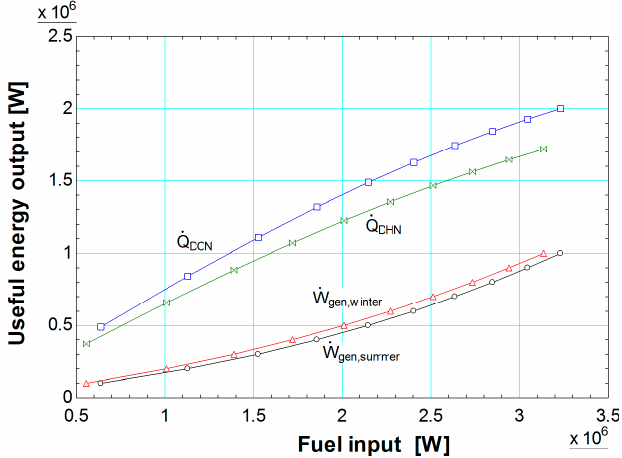
Figure 2. Simulation of the 1 MW e combined cooling, heating, and power system at part ‐ load and full ‐ load: fuel input vs. useful energy output.